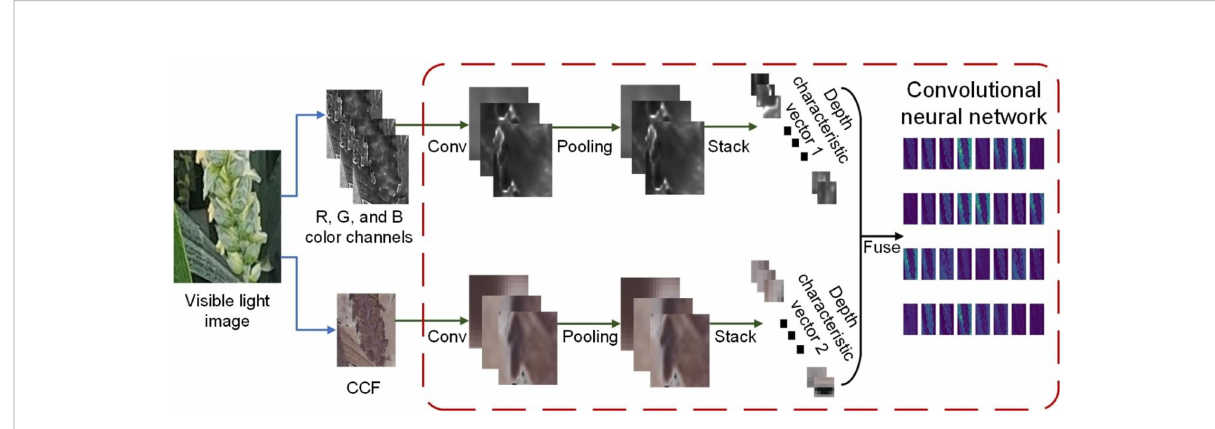
FIGURE 5 The overall schematic diagram of feature fusion